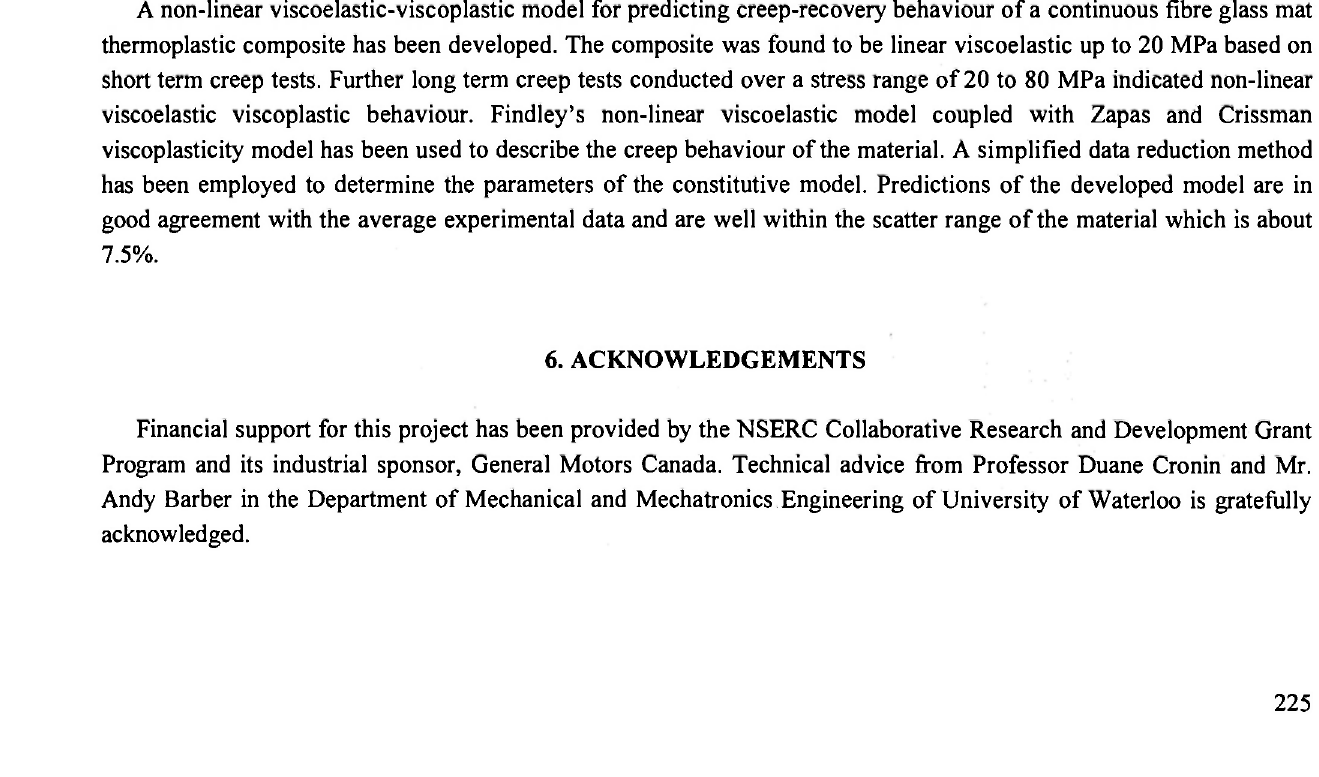
Fig. 11: Average experimental, elastic, viscoelastic and viscoplastic strains at 70